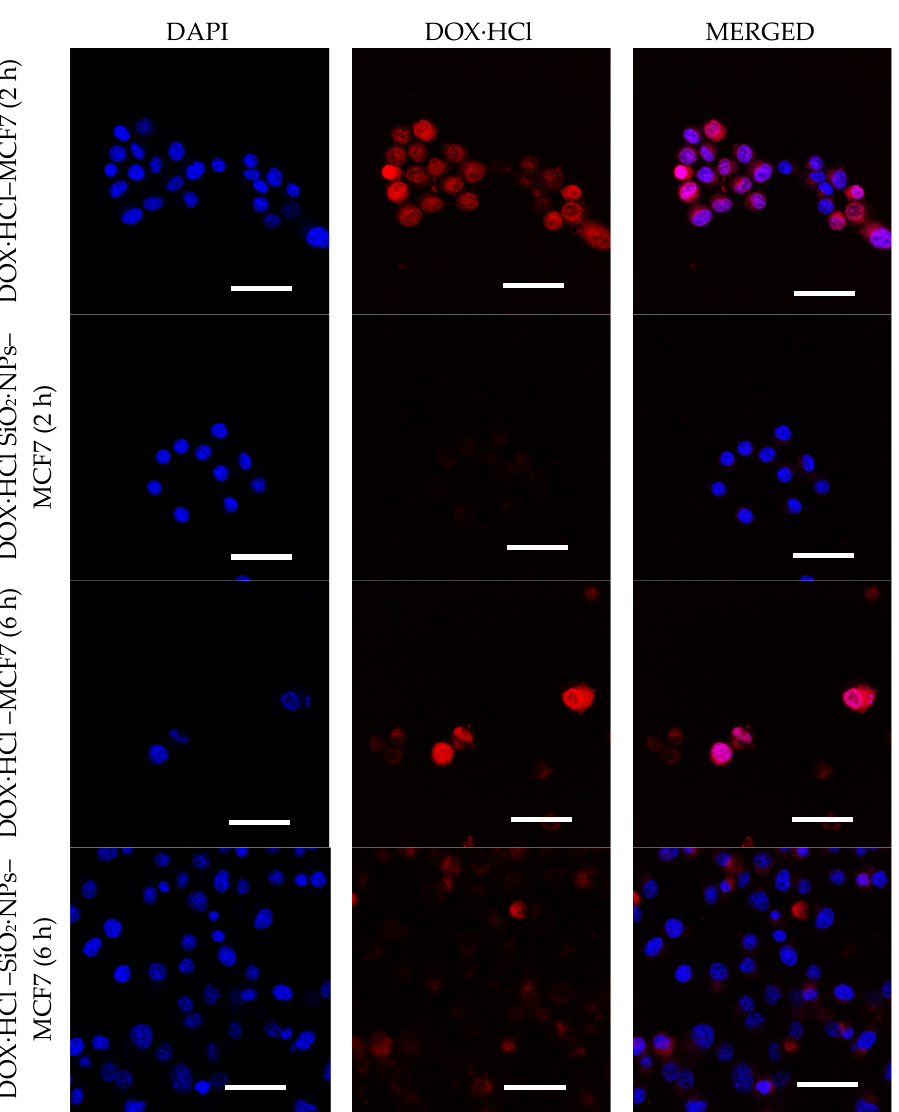
Figure 7. CLSM images of MCF7 cells incubated with DOX · HCL molecule (on top), DOX · HCl–SiO 2 NPs system (bottom) at DOX · HCl concentration of 4 µ M. Images were acquired after 2 and 6 h. (Nuclei of these cells incubated with DAPI molecules). Scale bar 50 µm.